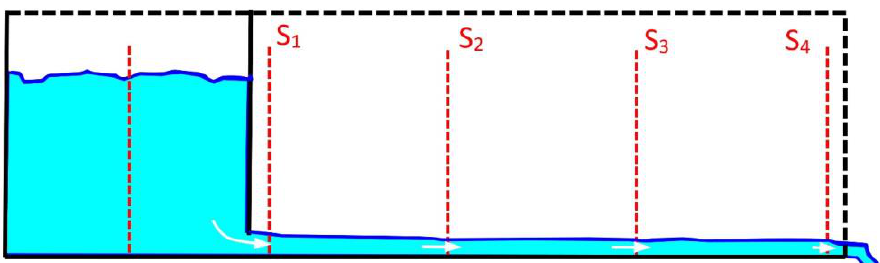
Figure A1. Test rig for outflow tests. The instrumented four sections are denoted S 1 ...S 4 , from left to right.